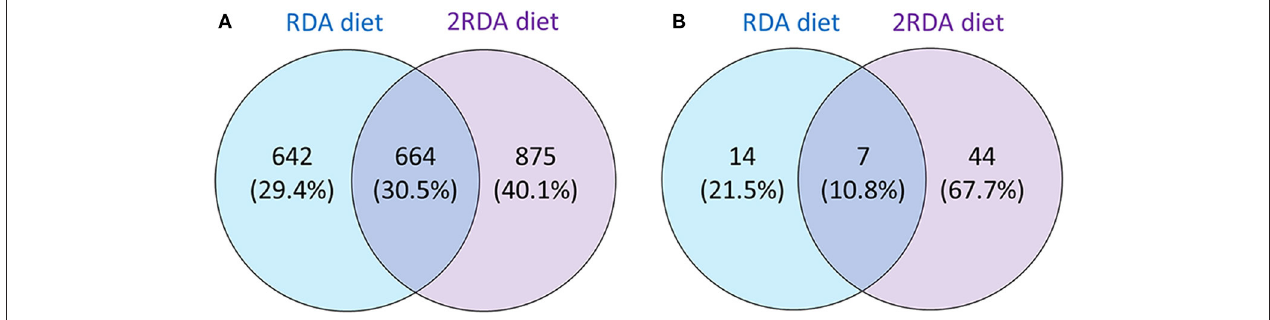
FIGURE 2 | Showing the number of all identified proteins unique to each diet or common to each diet (A) ; and proteins present in at least 60% of one diet group ( n = 6 for both diet groups) observed in either one or both diet groups (B)